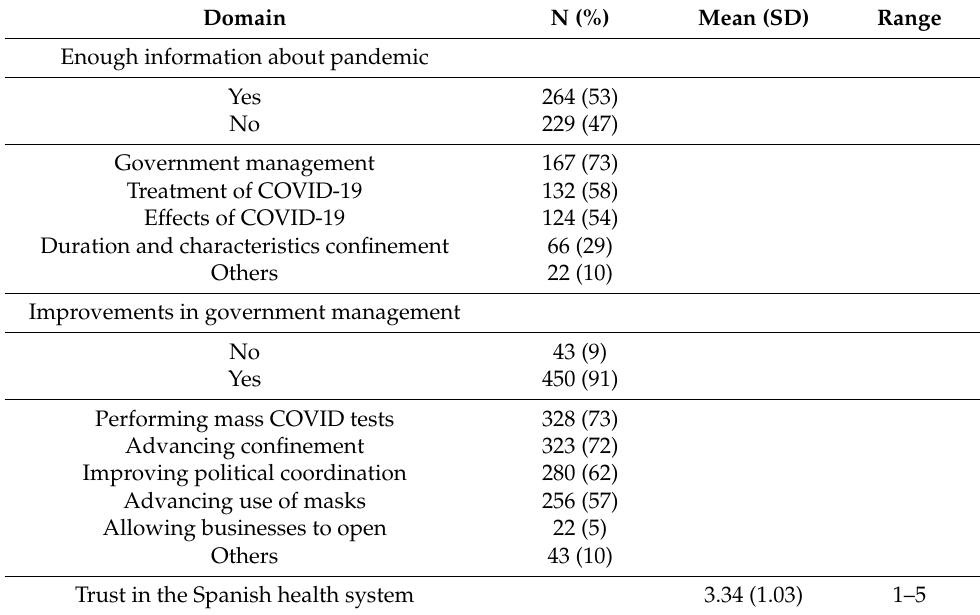
Table 6. Descriptor statistics for the variables about management of the pandemic (N =